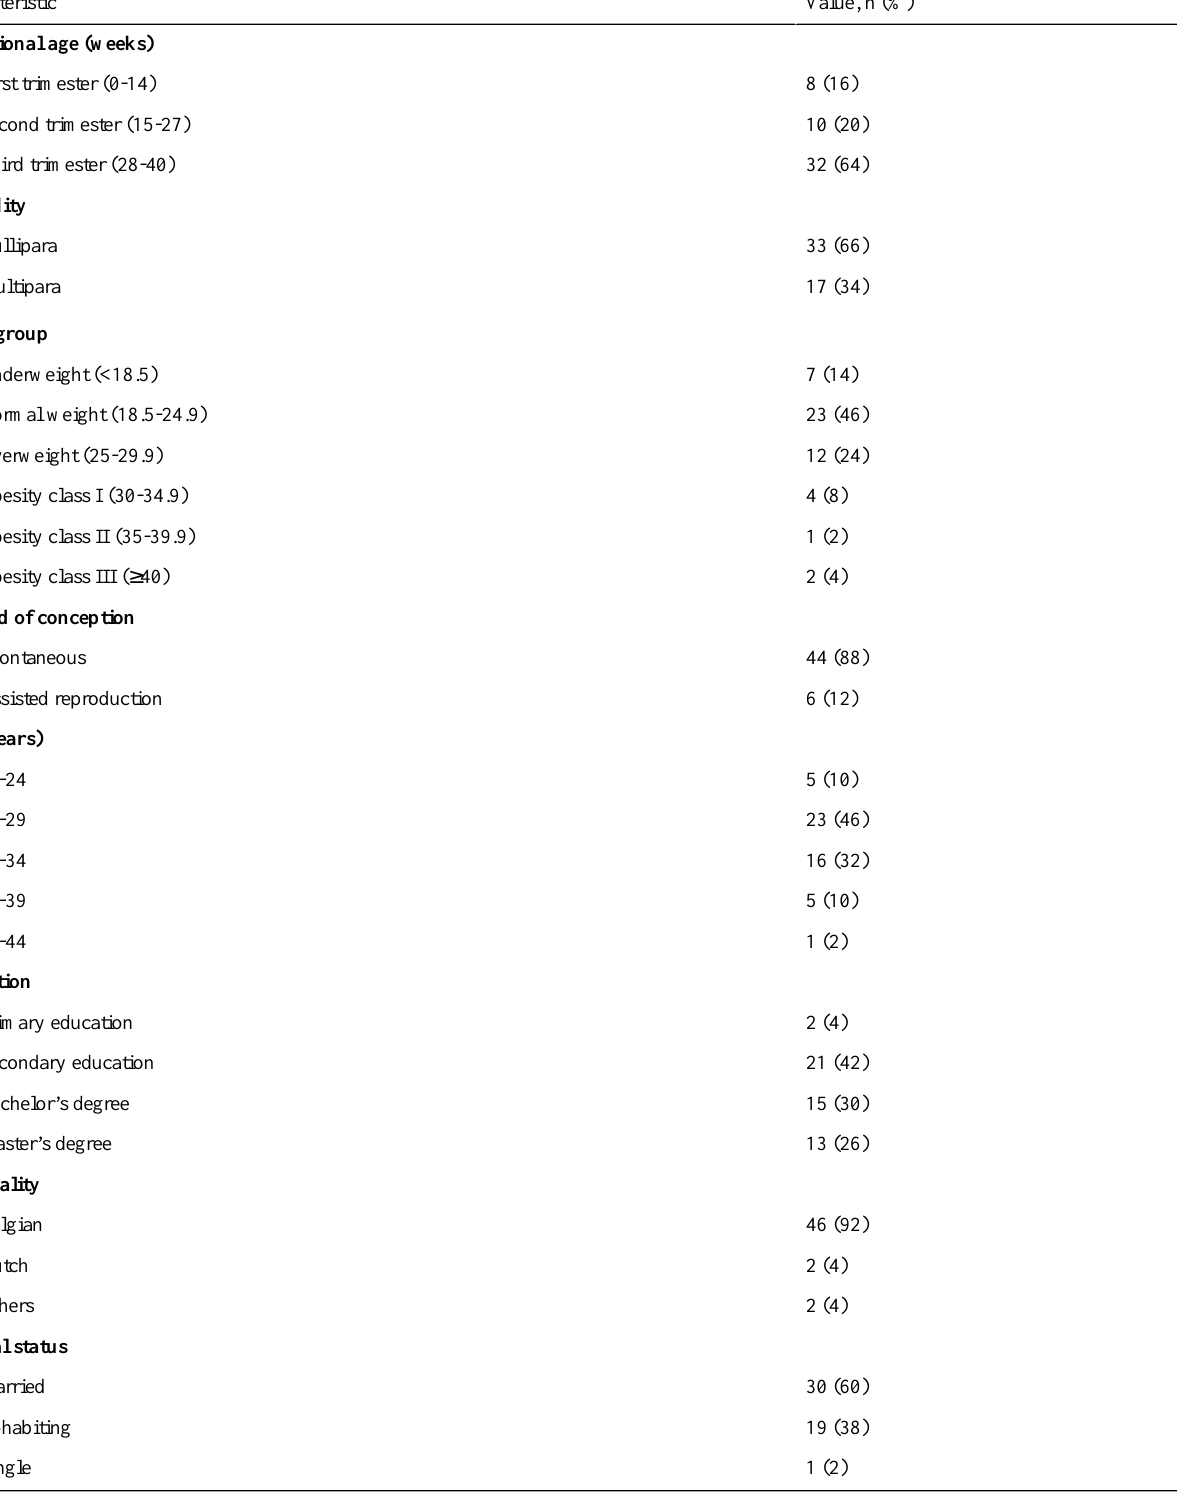
Table 3. Characteristics of the survey participants (pregnant women)